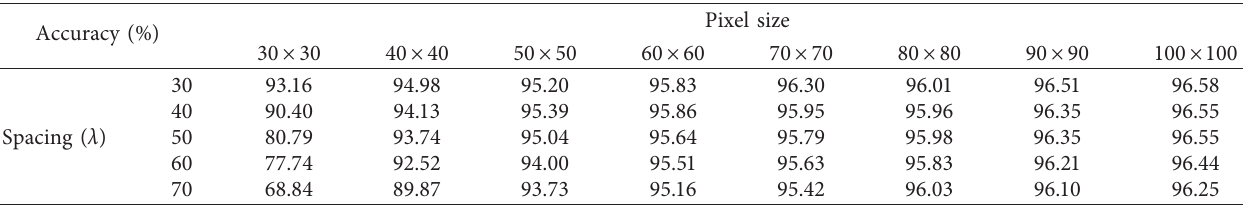
Figure 6: Classification accuracy corresponding to the number of raster layers with standard, Leaky-ReLU, PReLU, and RReLU activation function models. Table 7: The classification accuracy in the N-D 2 NN model adding the Leaky-ReLU activation function corresponds to pixel size and diffraction grating spacing.